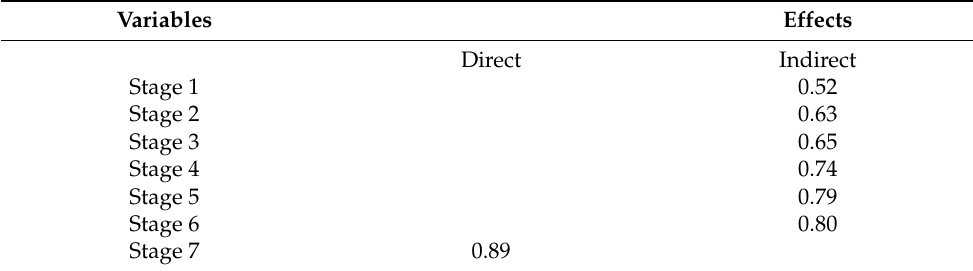
Table 2. The effects from previous seven stages to the eighth stage ( n = 292).